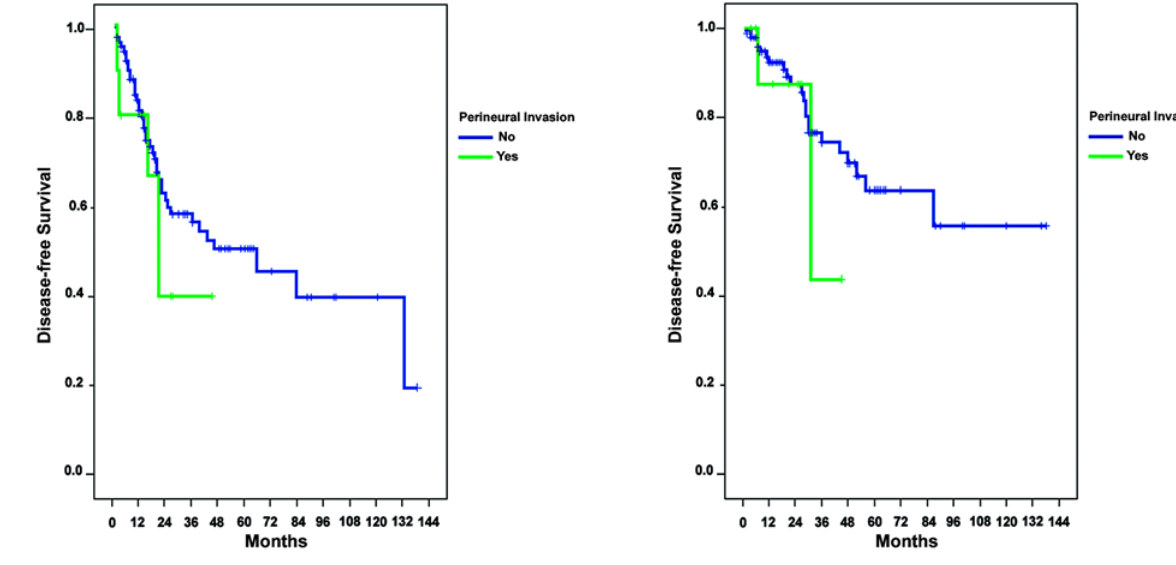
Figure 2 – Disease-free survival of patients with and without perineural invasion.